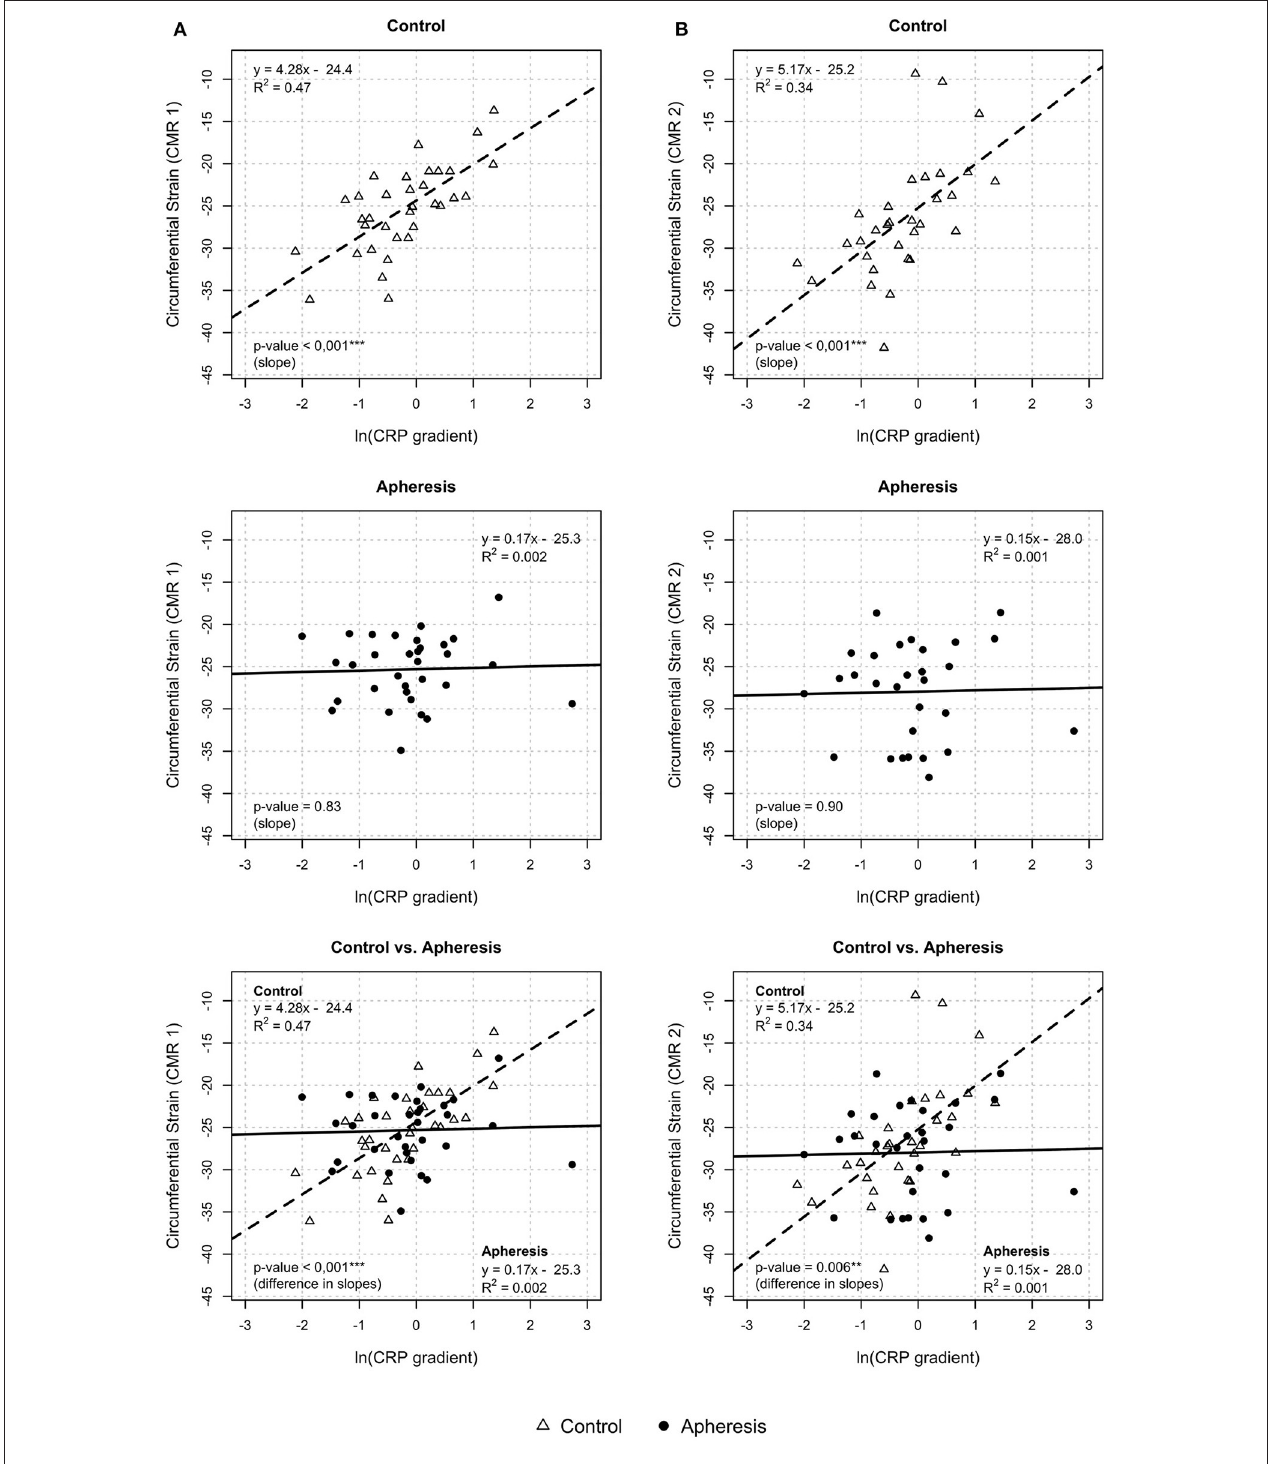
FIGURE 7 | Circumferential strain and CRP gradient [ln(CRP gradient)] at CMR1 (A) and CMR2 (B) . CMR 1—control group: Highly significant increase of circumferential strain with increasing values of the CRP gradient ( p < 0.001). Increase of ln(CRP gradient) by 1 unit led to an increase of circumferential strain by about 4.3 units. Apheresis group: Only small increase in circumferential strain with increasing CRP gradient ( p = 0.83). Importantly, the two linear models differ highly significantly ( p < 0.001). CMR 2—control group: Highly significant increase of circumferential strain with increasing values of the CRP gradient ( p < 0.001). Increase of ln(CRP gradient) by 1 unit led to an increase of circumferential strain by about 5.2 units. Apheresis group: No significant increase in circumferential strain with increasing CRP gradient ( p = 0.9). Importantly, the two linear models differ highly significantly ( p < 0.006).